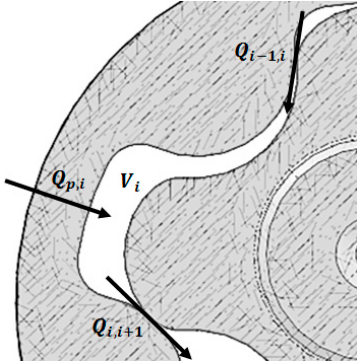
Figure 4. Flow rates balance for i -th chamber.